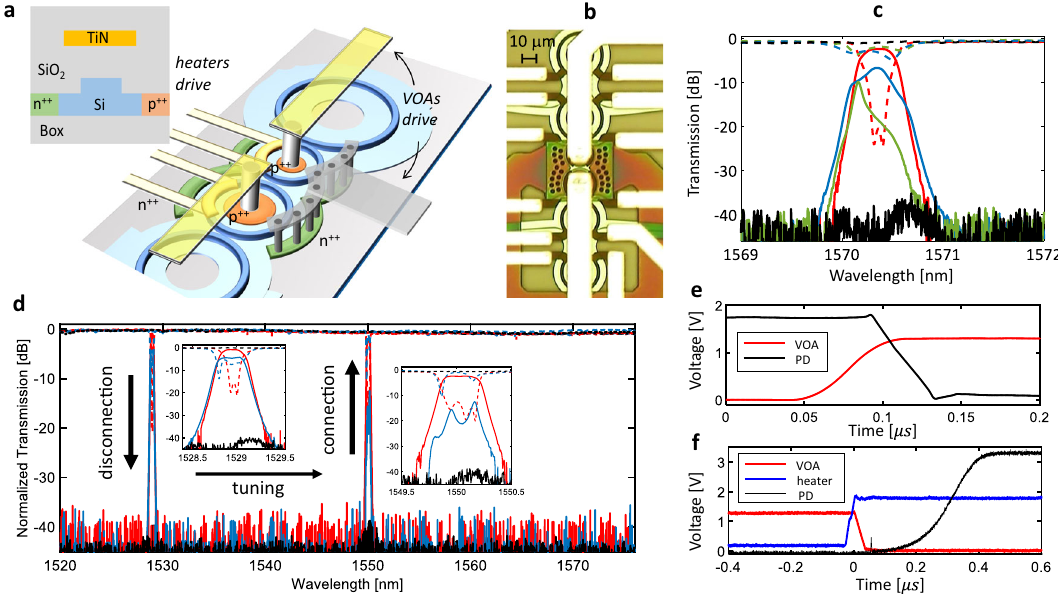
Fig. 2 Hitless tuning. a Scheme of a coupled MRR fi lter with integrated p-i-n junctions acting as VOAs in addition to integrated thermal actuators. The rib- waveguide cross section with the TiN heater and the doped regions is shown, whose dimensions are given in Supplementary Sec. 4. b Microscopic picture of the central section of the silicon photonic fi lter with integrated VOAs. c Measured spectral response of the fi lter at the Through (dashed) and Drop (solid) ports during the hitless operation at 1570.4 nm for different VOAs driving voltages: connected state (0 V, red), complete disconnected state (1.3 V, black), intermediate states (0.9 V, blue; 1 V, green). d Hitless recon fi guration of the fi lter from channel 60 (1529.55nm) to channel 34 (1550.12 nm) of the ITU-T grid performed without introducing perturbation to WDM channels in between. Time response of the VOA ( e ) turning-on process (loss increase, fi lter disconnection) and ( f ) turning-off (loss decrease, fi lter connection), improved by heater thermal compensation. (PD = photodetector connected to the output